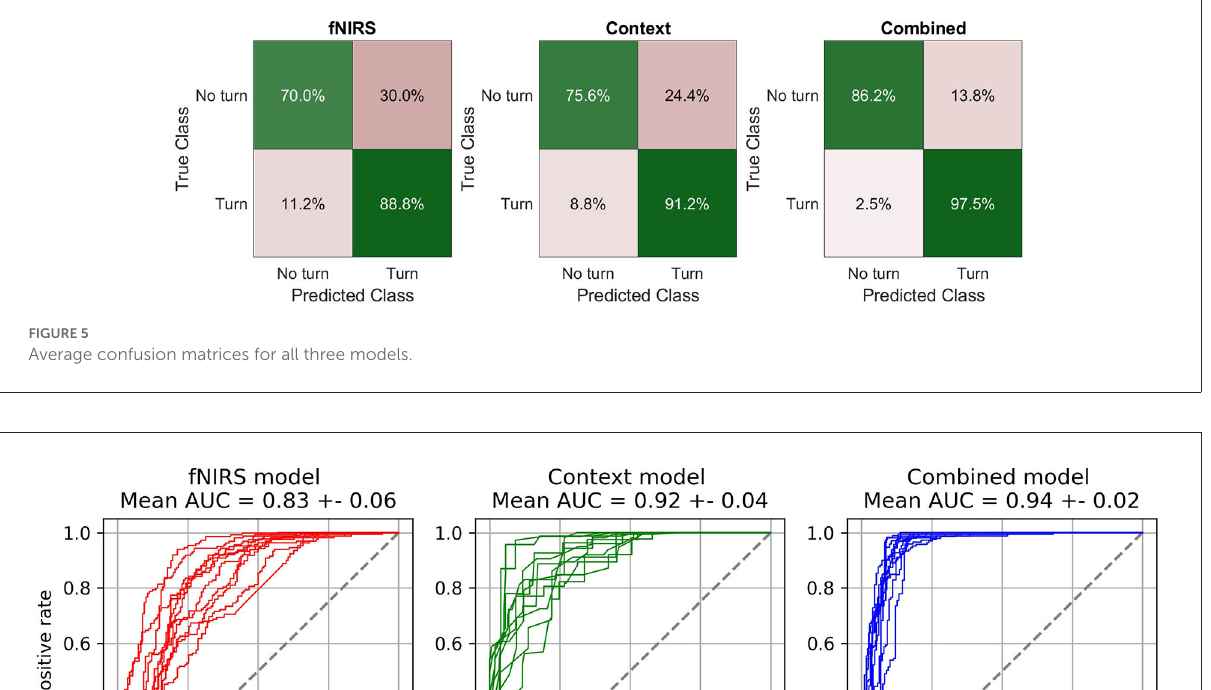
has the highest AUC with a value of 0.94 ± 0.02. The context model has a slightly lower AUC of 0.92 ± 0.04 but has larger variability across participants. The ROC curves of the context model for some participants have a comparable AUC to